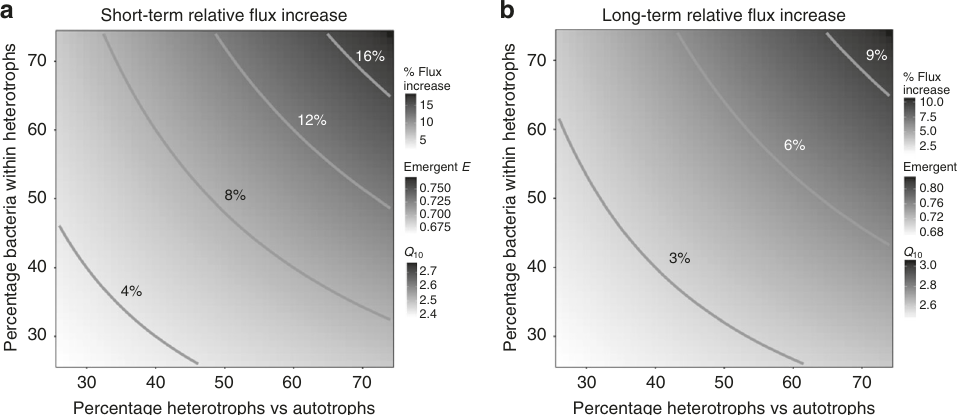
Fig. 6 Potential changes in ecosystem carbon fl ux due to differences in E between taxa. a Heatmap of % short-term increase in fl ux with 10 (cid:1) C temperature increase (as may occur during daily fl uctuations) of model ecosystems with bacteria having a different activation energy on average than eukaryotes, relative to ecosystems with all components having the same (0.65 eV) average activation energy. The fl ux change is shown over a range of ecosystem biomass compositions in terms of heterotrophs vs. autotrophs and bacterial proportion of the heterotrophs. The scale of emergent activation energies and Q fi ed fl ux are also shown. b Similar to a , but for long-term fl ux increase under a 4 °C warming scenario due to climate 10 s for the ecosystems with ampli change. Values for the short- and long-term thermal sensitivity of bacterial thermal responses used in these calculations are our estimated E S and E L , respectively, for mesophilic bacteria (Table 1). The mathematical model is described in the Methods